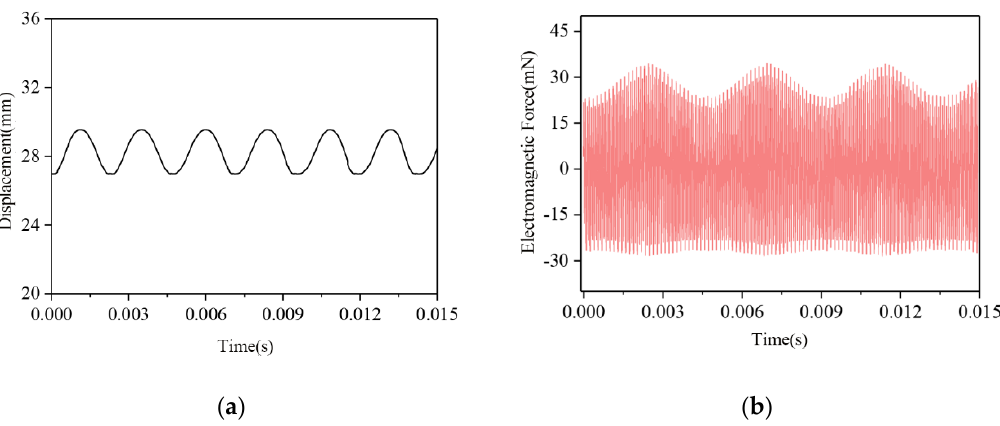
Figure 6. Displacement and force of iron object under electromagnetic attraction. ( a ) Horizontal displacement; ( b ) horizontal EMF.